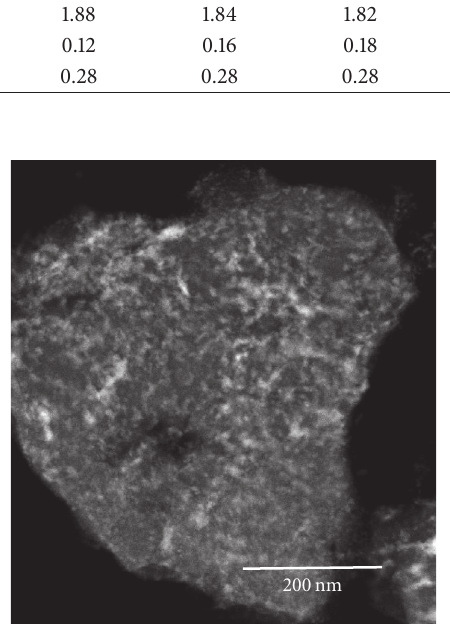
Figure 3: STEM cross-sectional dark field image of a composite- coated anode cut using a Ga